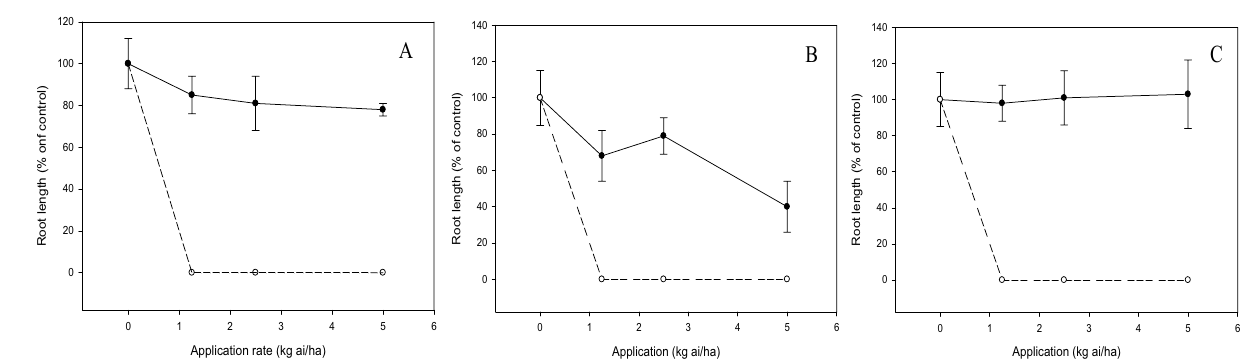
Figure 8. Herbicidal effects of c (solid line) and diuron (dashed line) treatments on root length of Eleusine indica ( A ), Oldenlandia verticillata ( B ), and Cyperus iria ( C ) respectively 2 weeks after pre-emergence